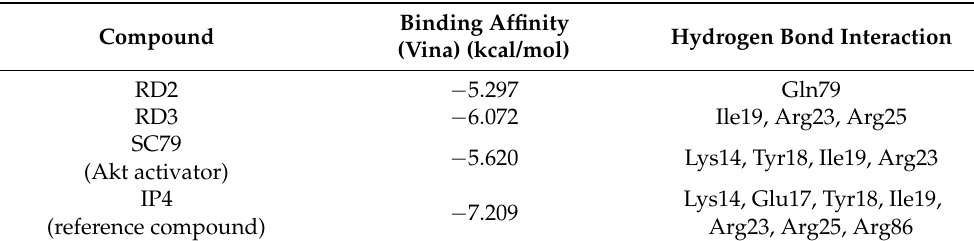
Figure 11. RD2 inhibits Akt activity via interaction with the allosteric binding site of Akt-1 ( a ) Co- crystal structure of miransertib (allosteric inhibitor) in Akt-1 (PDB 5KCV). ( b ) The original ligand (green) and redocking (blue). ( c ) Superimposition of miransertib, resveratrol (pink), and RD2 (red). The binding mode of compounds miransertib ( d ), resveratrol ( e ), and RD2 ( f ) in the allosteric bind- ing site of Akt-1. The PH domain is shown in green, the kinase domain in blue. The green dashed lines indicate hydrogen bonds. Table 3. The binding affinities of ligands docked with the PH domain of Akt-1 . Table 3. The binding affinities of ligands docked with the PH domain of Akt-1.